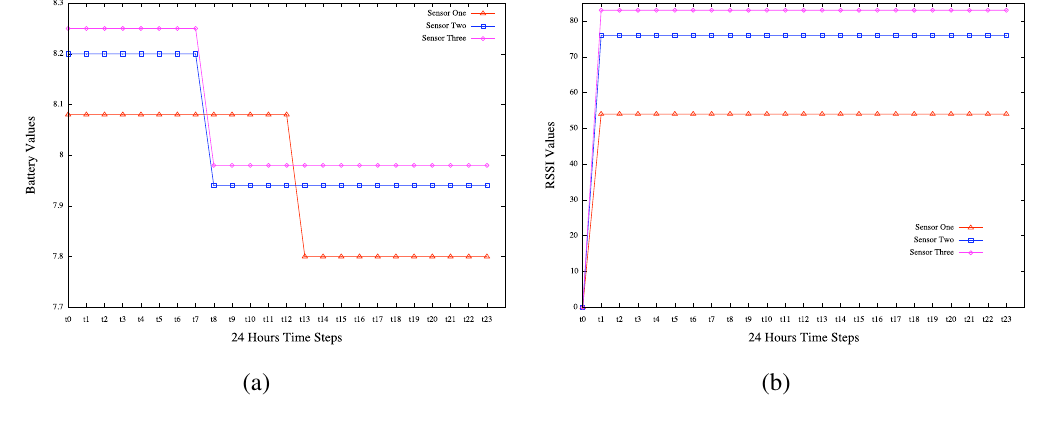
Figure 13. System Situation Awareness for day3: Scenario1. (a) Battery Life Awareness; (b) Signal Strength